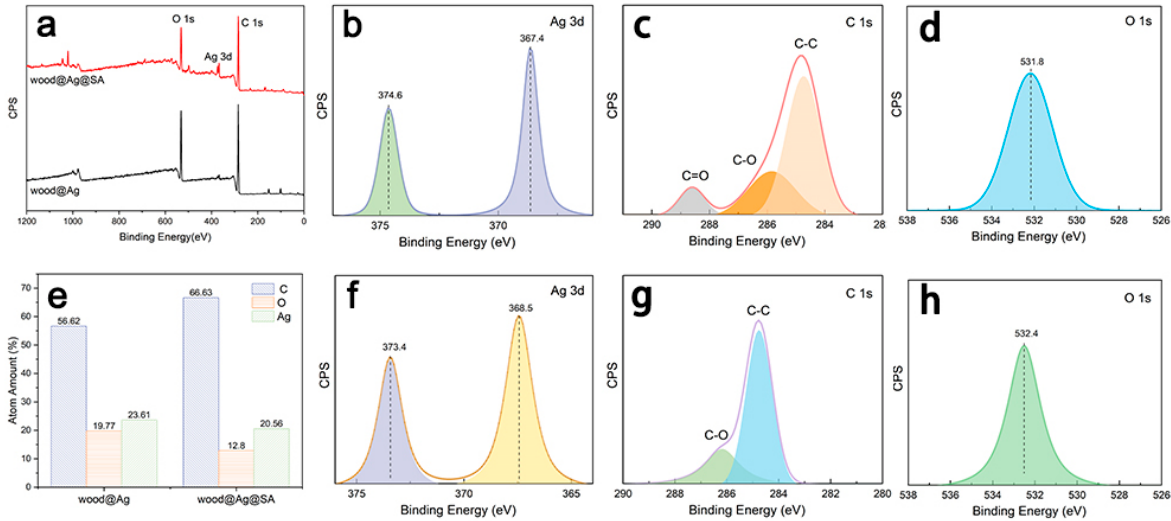
Figure 2. ( a ) The XPS survey of wood@Ag and wood@Ag@SA; ( b ) Ag 3d XPS spectra of wood@Ag; ( c ) C 1s XPS spectra of wood @Ag; ( d ) O 1s spectra of wood@Ag; ( e ) the atom amount distribution of wood@Ag and wood@Ag@SA; ( f ) Ag 3d